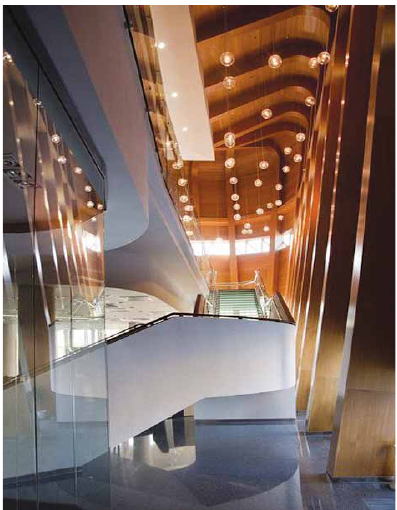
22 pav. Šachmatų klubo Chanty Mansijske interjeras, Rusija, archit. E. van Egeraat, 2010 m. Fig. 22. Chess club, interior view, Chanty Mansijsk, Russia, archit. E. van Egeraat, 2010